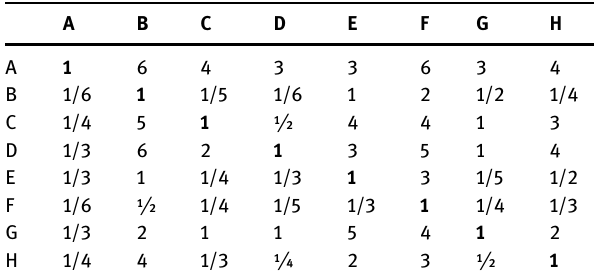
Table 2: Decision matrix ( pairwise comparison matrix